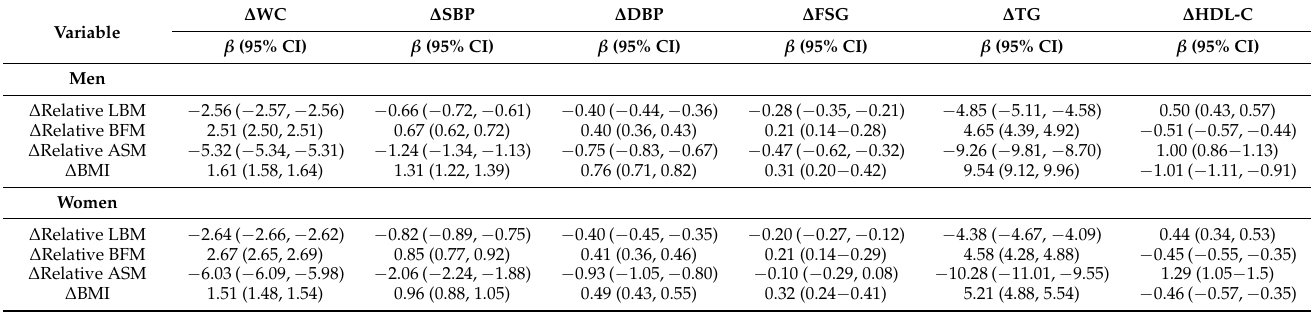
Table 2. Multiple linear regression models for the predictors of metabolic